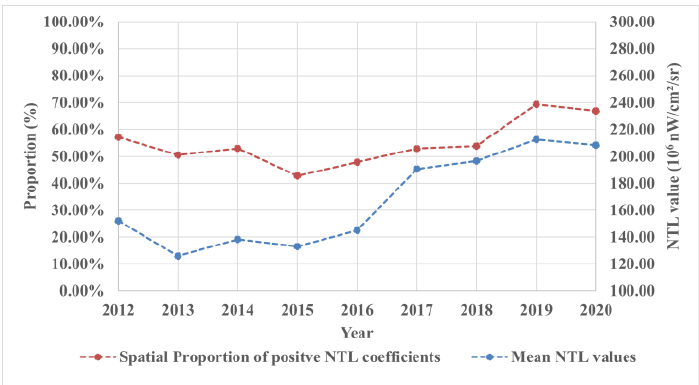
Figure 7. Temporal trends of mean NTL values and spatial proportion of positive NTL coefficients.